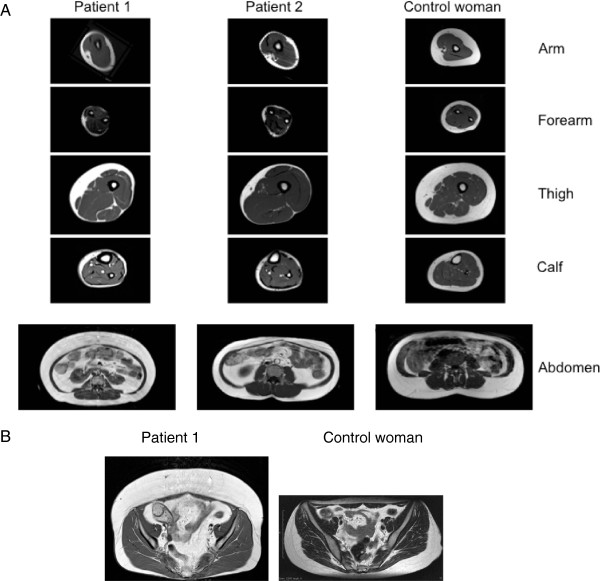
Body fat distribution of patients: magnetic resonance imagery (MRI). (A). T1-weighted MRI axial scans through the arm, forearm, thigh, calf and abdomen of patients 1 and 2, compared with a control woman of similar age (35 yr-old) and BMI (23 kg/m2). Partial lipoatrophy affecting the four limbs, contrasting with accumulation of intra-abdominal fat, was evidenced in both patients. Increased subcutaneous abdominal fat was also striking in patient 1. Bone marrow fat was well preserved. (B). T1-weighted MRI pelvic axial scan in patient 1 and in a control woman (BMI 21 kg/m2), showing lipoatrophy of gluteal fat depots with accumulation of anterior abdominal subcutaneous fat in patient 1.